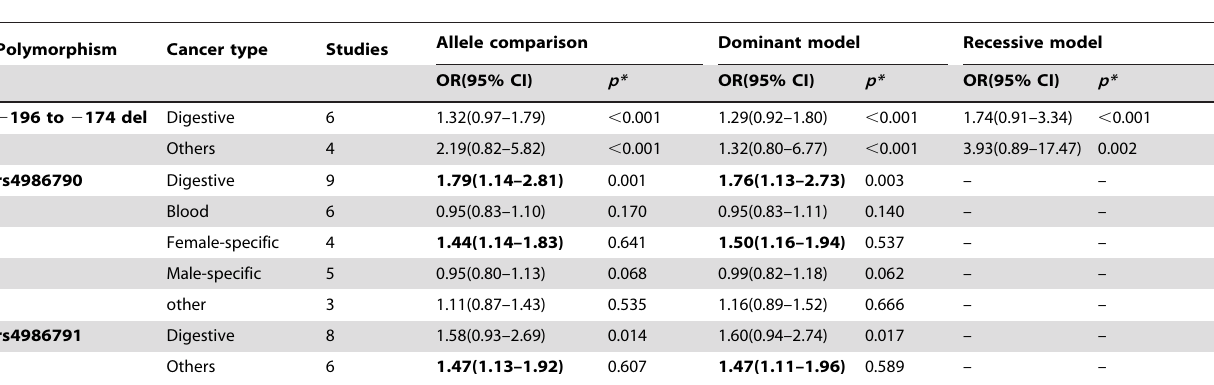
Table 3. Associations between TLRs polymorphisms and overall cancer risk by cancer types.